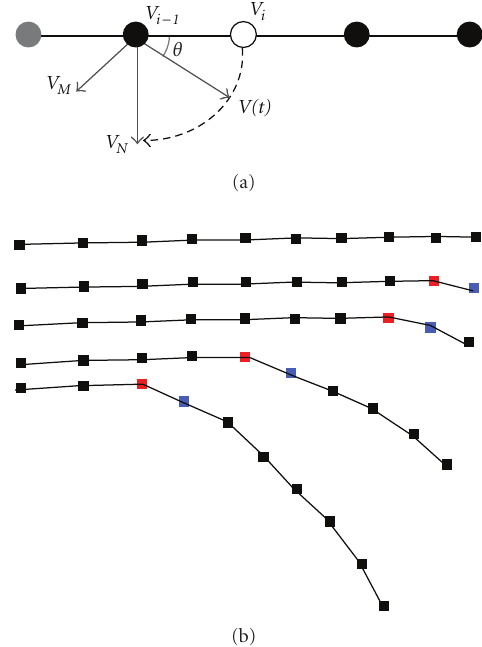
leaf. The banding is based on the distance of each vertex to the venation skeleton. In other words, each vertex in the mesh is banded to the nearest vertex in the venation skeleton. Figure 3 gives an example of banding a leaf mesh to its venation skeleton which consists of a midvein and two secondary veins.